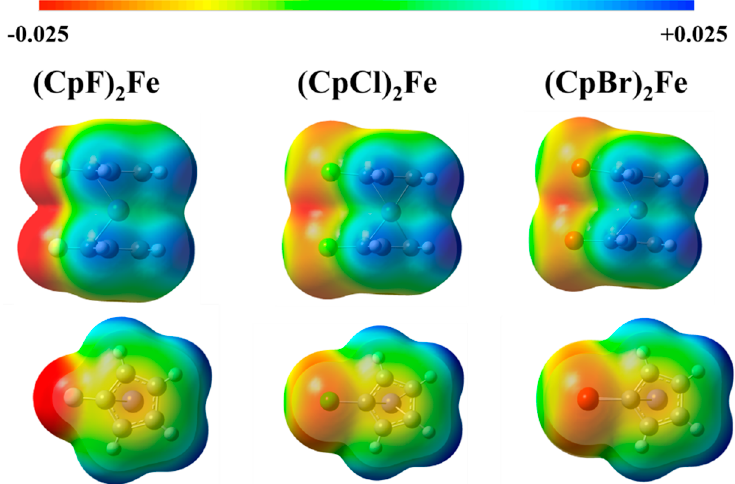
Figure 1. Electrostatic potential mapped onto an electron density isosurface for (CpX) 2 Fe (side and top views, X = F, Cl, Br). Positively or negatively charged regions are indicated by colour gradients changing from blue to red, respectively (scale in atomic charge unit/Å 2 ). The isosurface depicted in this and the following map figure correspond to the isodensity of 0.0004 relative to the total electron density.